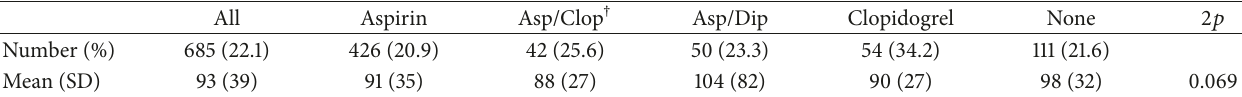
Table 5: P-selectin (median fluorescence) with no stimulation, by antiplatelet medication taken prior to randomisation, whether before or after stroke/TIA. Data are number (%) or mean (standard deviation). Comparisons by one-way analysis of